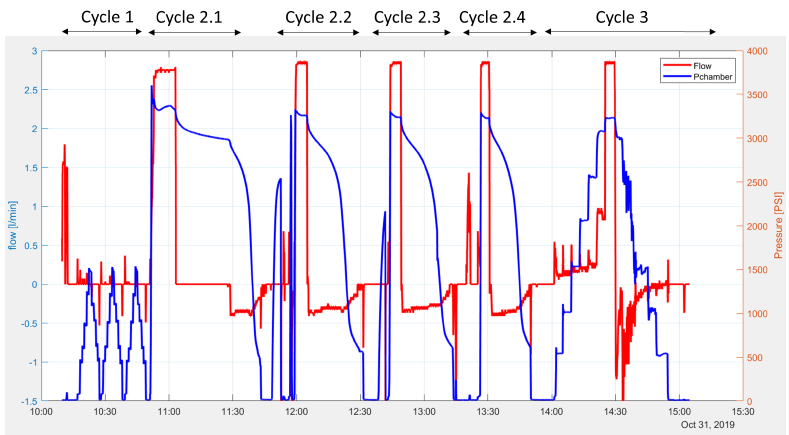
Figure 25. Borehole TV 4100 test 4 injection tests [47].